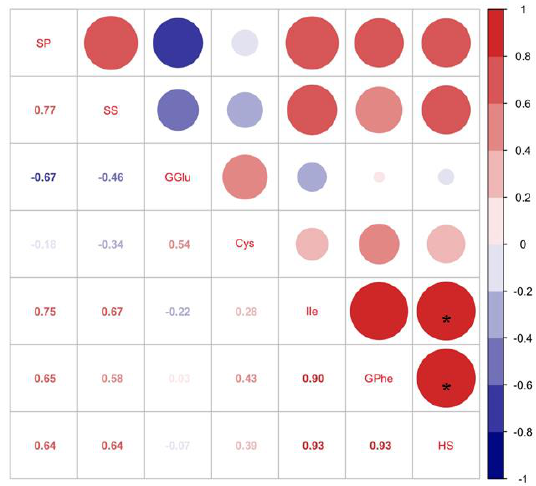
Figure 3. Pearson correlations between nutrients in soybean and host selection of C. bilineata tsing- tauica larvae (SP: soluble protein; SS: soluble sugar; GGlu: glutamic acid in soybeans G. max ; Cys: cysteine; Ile: isoleucine; GPhe: phenylalanine in G. max ; HS: host selection of C. bilineata tsingtauica for soybean). The size of the blocks corresponds to the values in the figure, which represent the correlations between key plant VOCs and larval host selection and nutrients. Red blocks indicate positive correlations, blue blocks indicate negative correlations, and the asterisks within the blocks indicate significant correlations at p <